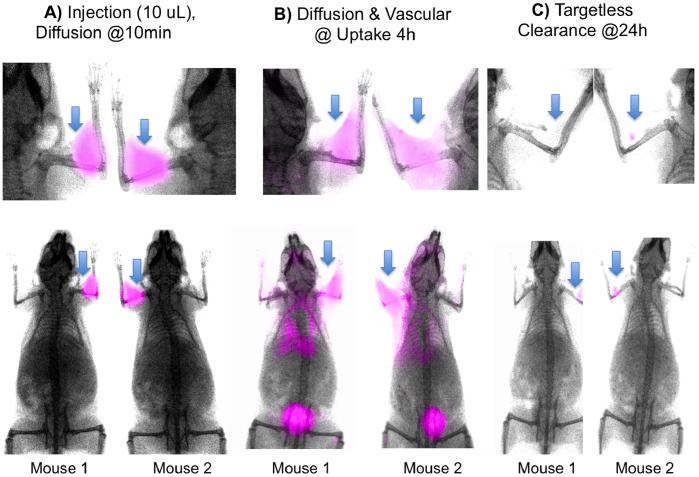
Visualizing of probe interstitial diffusion by surface fluorescence.Diffusion of the control RAD probe after a single IM injection (arrows) into the front extremities (50 pmole/10 µl/injection) are shown. Times post injection were 10 min (A), 4 h (B) and 24 h (C). Injection sites (arrows) show a lack of fluorescence at the injection site at the clearance phase.